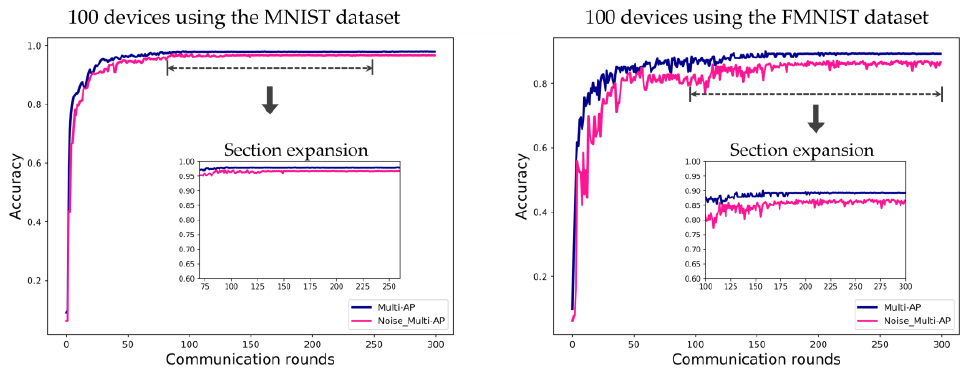
Figure 8. Evaluation of FL accuracy convergence using the MNIST and FMNIST datasets in envi- ronments with ten APs, for 100 communication rounds. Label ‘Multi-AP’ is the system with a good channel environment as proposed method, and label ‘Noise_Multi-AP’ means a system with a poor channel environment as the comparison.